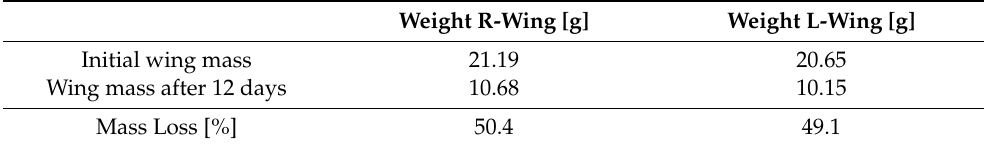
Table 1. Characteristics of the wings during the freeze-drying method.